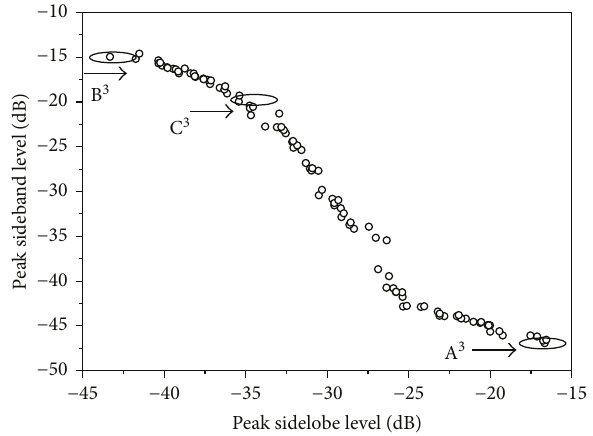
Table 9: The normalized switch-on time sequences for individuals